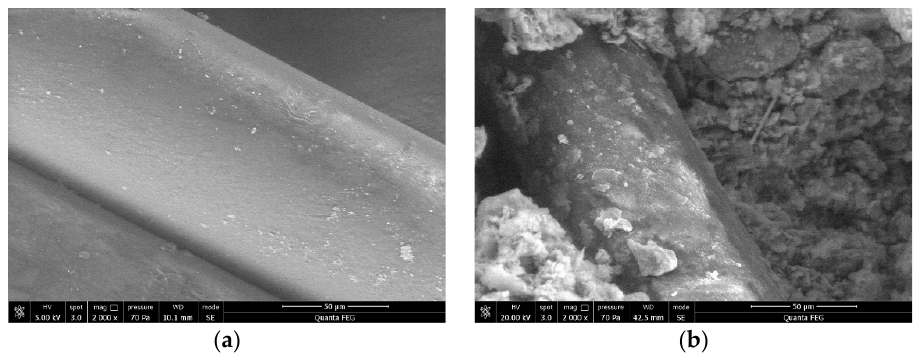
Figure 9. Microstructure of fracture surface after flexural strength test: ( a ) prior failed specimen; ( b ) optimum mixture design specimen.